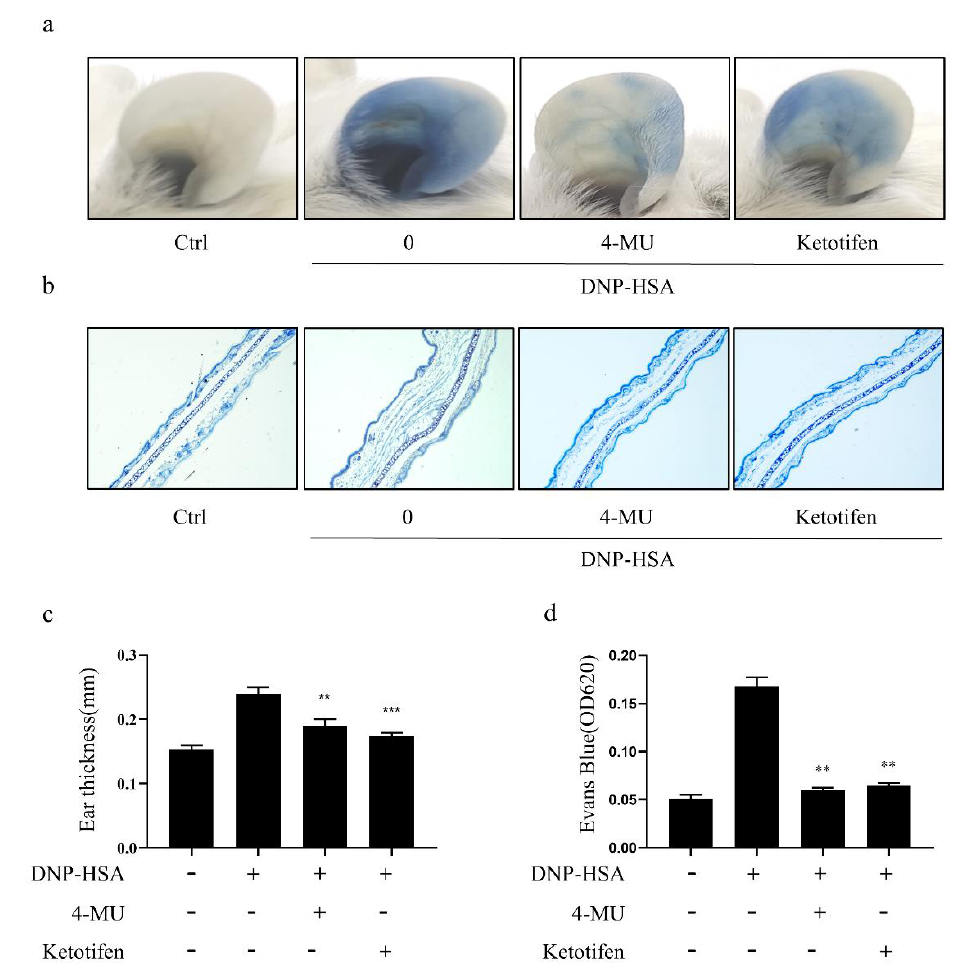
Figure 5. 4-MU attenuation of IgE-mediated allergic reactions in PCA mice [sensitized with anti-DNP-IgE (or saline control) for 12 h, 4-MU for 1 h, and injected with DNP-HSA/0.5% Evans blue]. ( a ) Representative photos of showing dye extravasation from ears. ( b ) Representative photomicrographs of sections from PCA ears. ( c ) Reversal of DNP-HSA-induced increases in ear thickness. ( d ) Formaldehyde-extracted Evans blue dye quantified at 620 nm. Means (of three independent experiments) ± SD are shown; ** p < 0.01, *** p < 0.001 vs. activated cells, not treated. Abbreviations as in Figure 1.